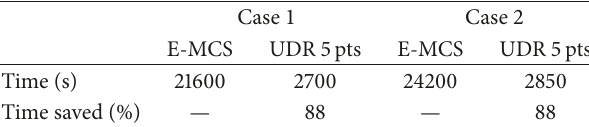
Table 2: Approximate run time for each practical session.